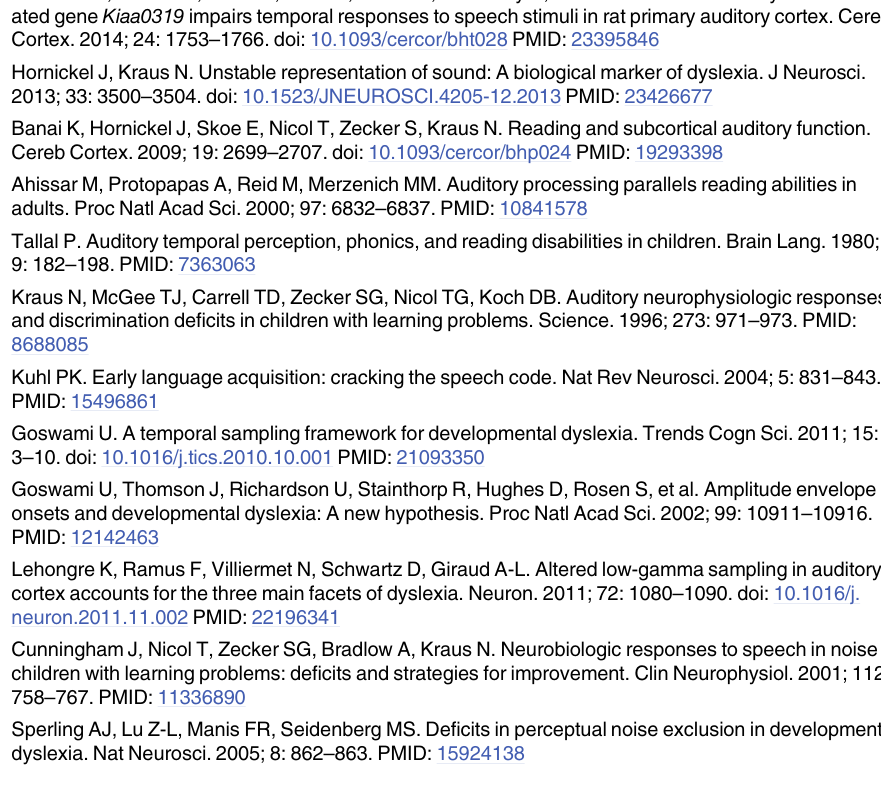
S2 Table. Results of preliminary modeling that led to the regression model reported in Experiment 1. Neural timing (Step 2A), representation of the first formant (Step 2B), and neu- ral stability (Step 2C) each predict phonological processing in isolation, over and above